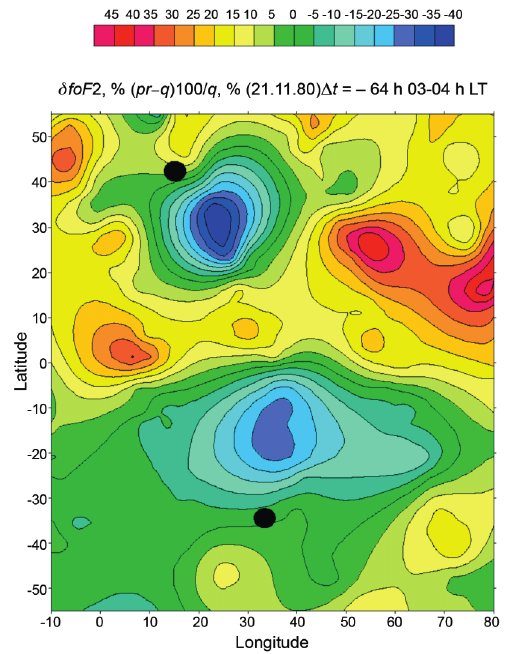
Fig. 7. Formation the conjugated modified area in the Southern Hemisphere before the Irpinia earth- quake 23rd November 1980, M = 6.9. Data from In- tercomos-19 satellite topside